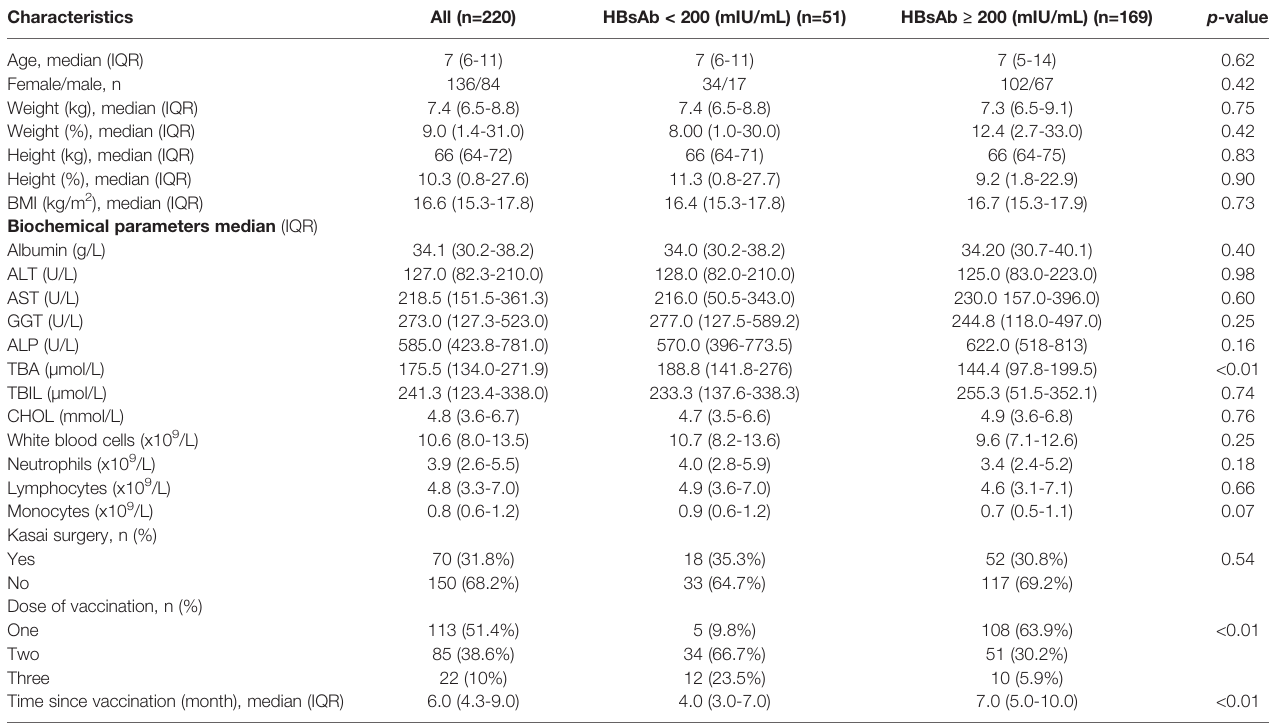
TABLE 2 | Factors affecting immune response to HBV vaccine. Characteristics